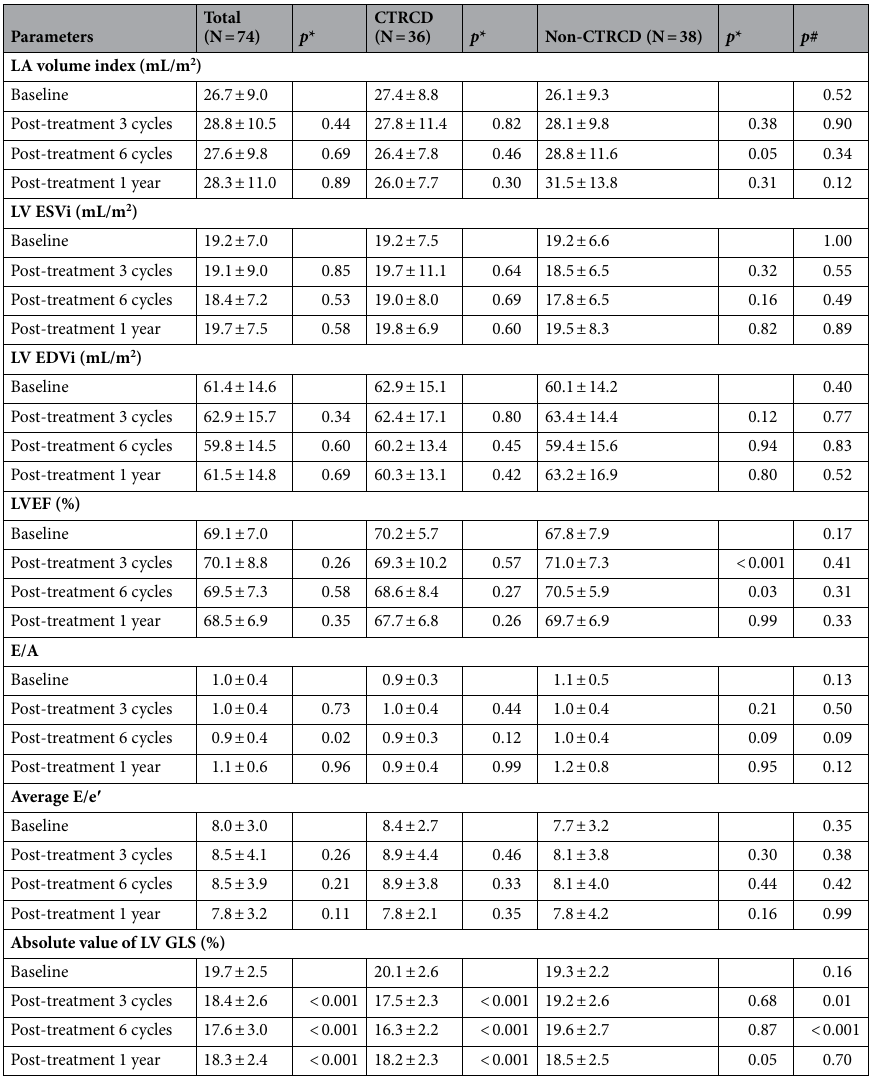
Table 2. Longitudinal follow-up results of echocardiographic studies. Data are expressed as mean ± SD or number (%). CTRCD indicates cancer therapy-related cardiac dysfunction; EDVi, end-diastolic volume index; EF, ejection fraction; ESVi, end-systolic volume index; GLS, global peak systolic longitudinal strain; LA, left atrial; LV, left ventricular. p *: comparison between the tested value and the baseline value. p #: comparison between the subtle LV dysfunction group and the non-subtle LV dysfunction